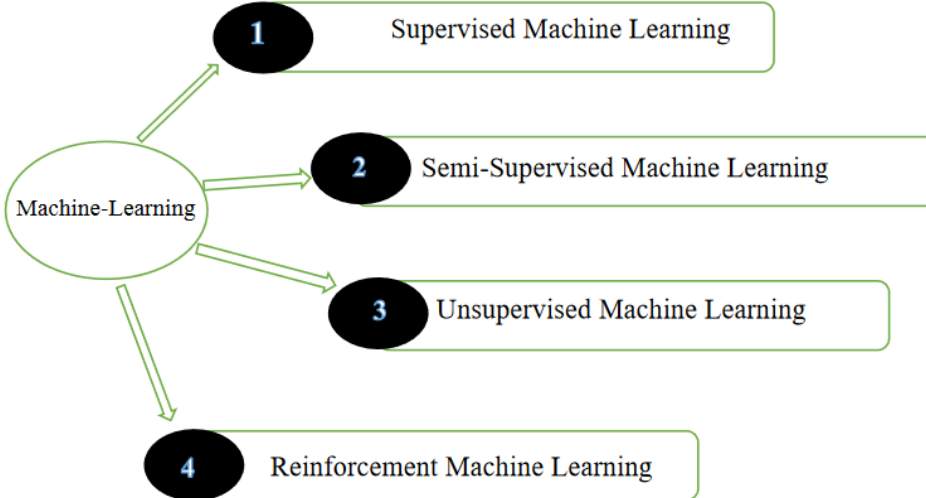
Figure 7. Classification of artificial intelligence and machine